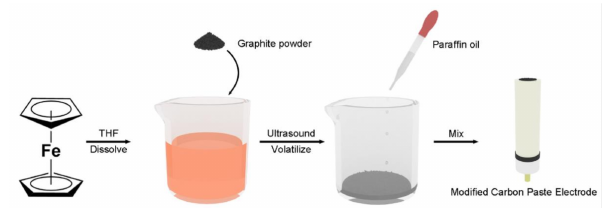
Figure 1. The preparation process of modified carbon paste